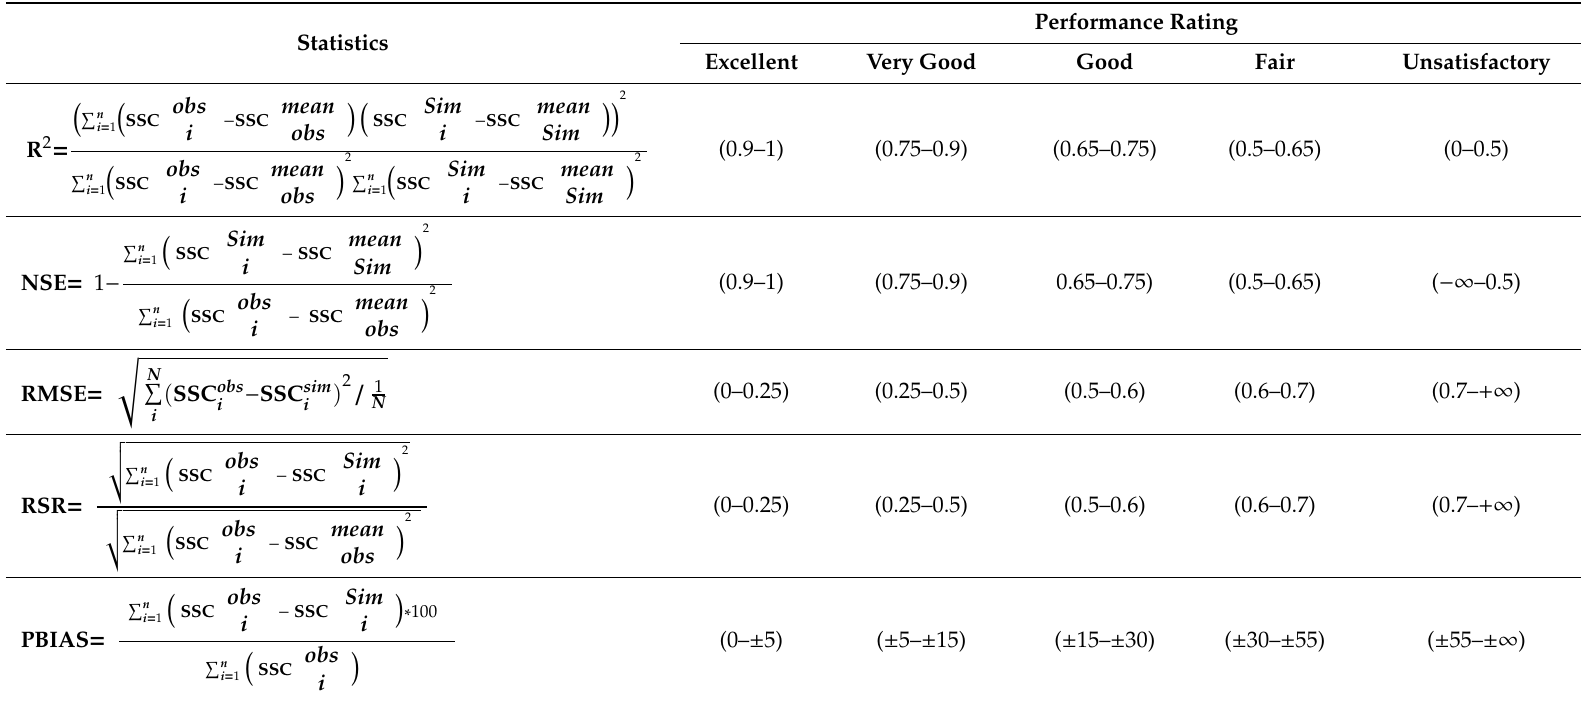
Table 1. General performance ratings for recommended statistics to evaluate models